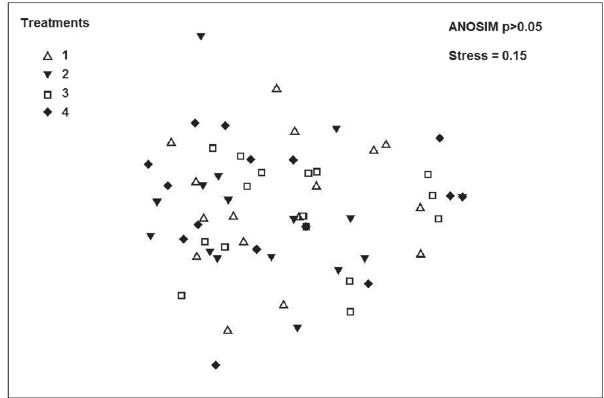
Fig. 2. Results from multivariate analysis nMDS (nonmetric multidimensional scaling) for fish collected in January and July 2010, downstream from Itutinga Dam, Grande River, in the four flow rate treatments (1 - constant flow rate in January; 2 - hydropeaking in January; 3 - constant flow rate in July; 4 - hydropeaking in